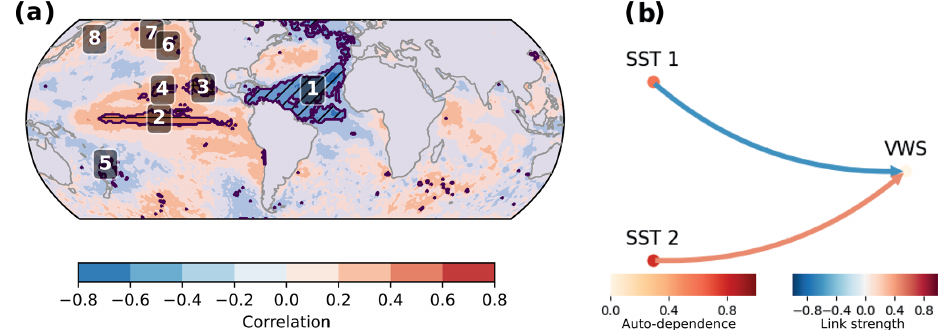
Figure 3. Precursors of VWS MDR in a training set containing the years 1979–2015: (a) pointwise correlation between SSTs in May and VWS MDR averaged over July–October. Labels indicate clustered regions that are treated as potential precursors. (b) Robust precursors of VWS MDR as detected by our method. The colour of the arrows indicates the link strength, and the colour of the nodes indicates the strength of auto-dependence. The link strength (including auto-dependence of variables) is calculated following Runge et al. (2019) using partial correlations. This was shown to give a normalised measure of causal strength ranging between − 1 and 1. For visualisation purposes only ingoing links of VWS MDR are shown here; the full network is shown in Fig. S1 in the Supplement.